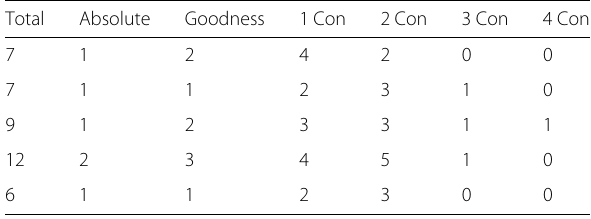
Table 3 Outcome of 5 Queries in “Account”